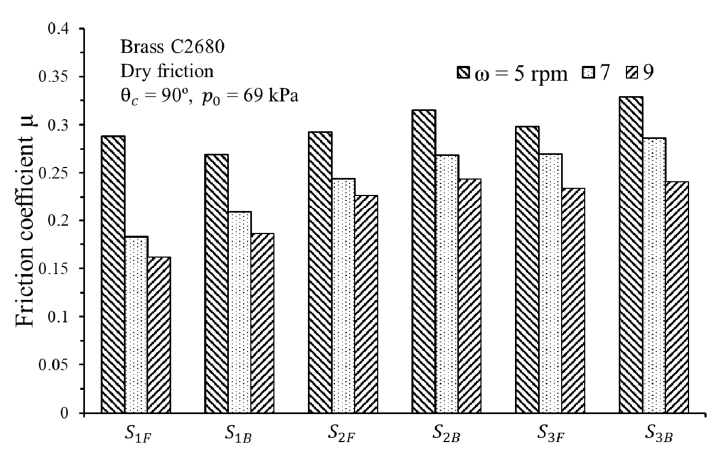
Figure 9. E ff ects of rotation speed on friction coe ffi cient under dry friction conditions. Figure 9. Effects of rotation speed on friction coefficient under dry friction conditions.